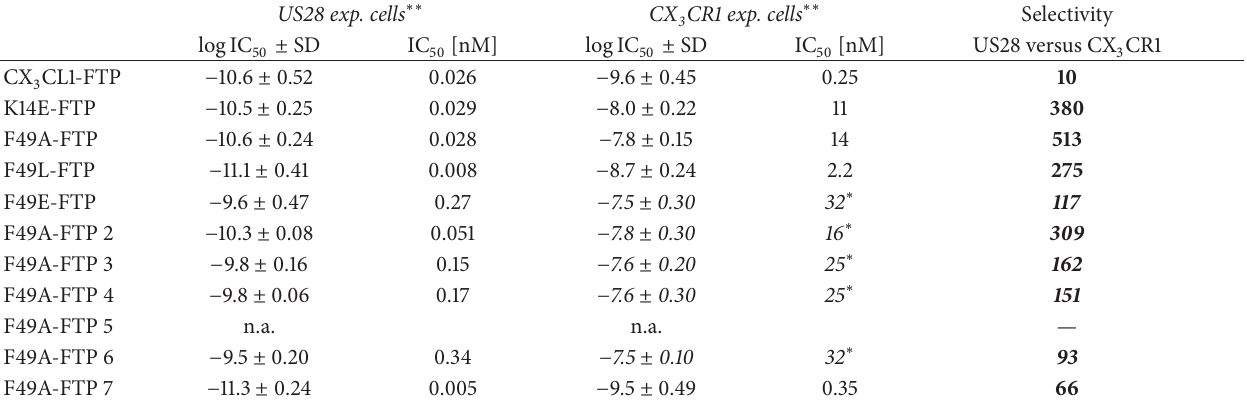
Table 2: Cell killing activity of the FTPs.